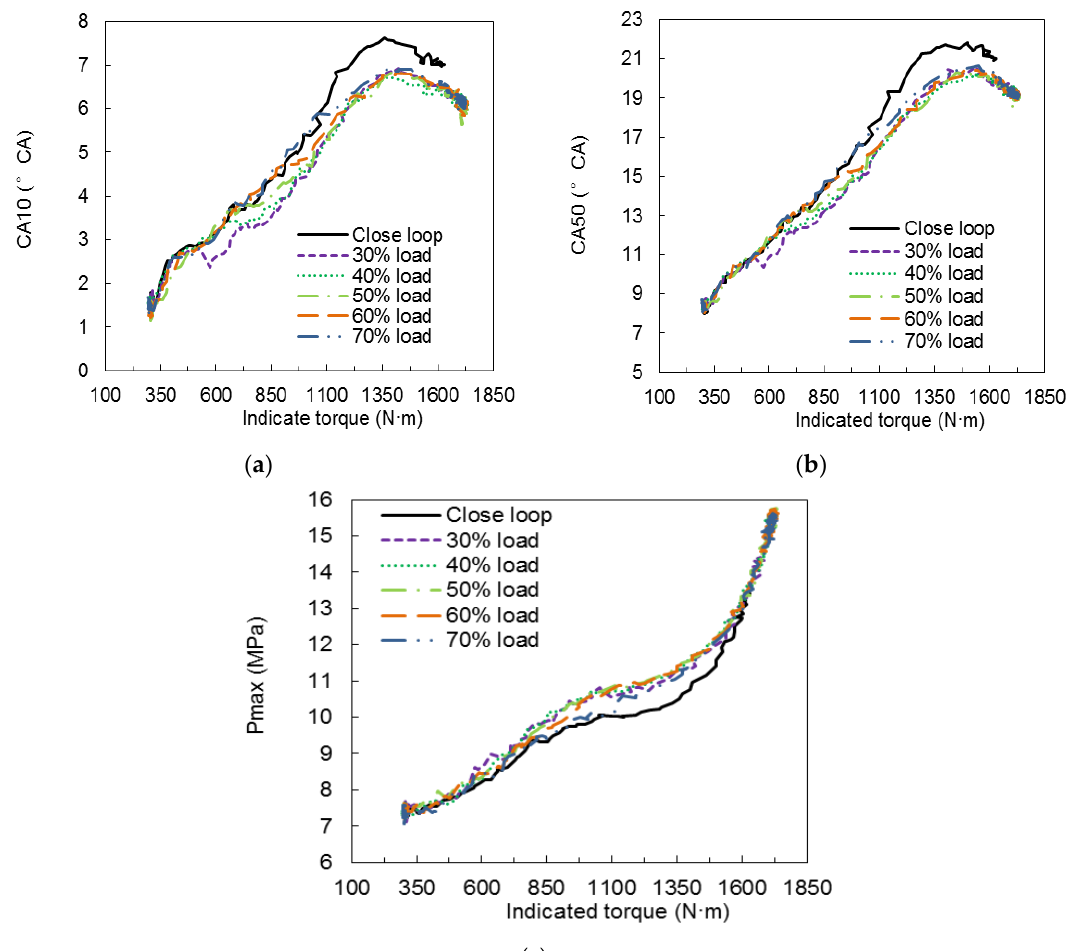
Figure 11. Effect of SSRP strategy on combustion performance: ( a ) CA10; ( b ) CA50; ( c ) Pmax.